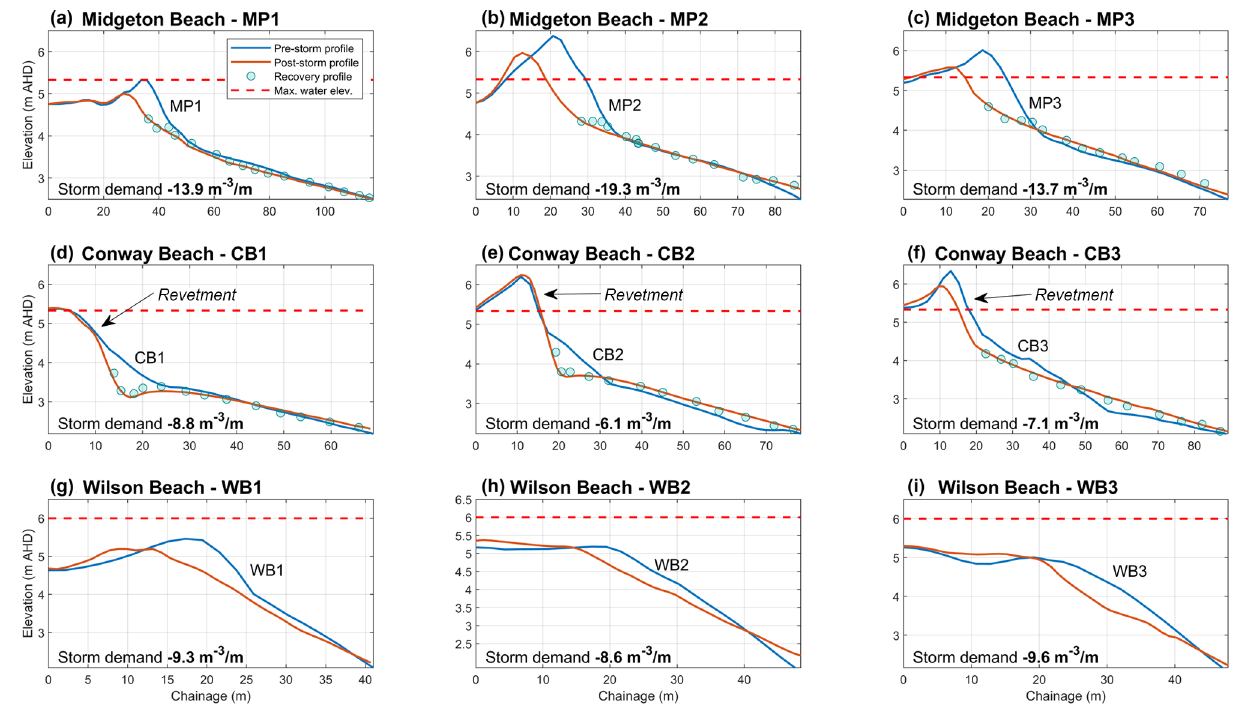
Figure 8. Cross-shore beach profile change at Midgeton Beach ( a – c ), Conway Beach ( d – f ) and Wilson Beach ( g – i ). Blue (orange) lines denote pre- (post-) storm profiles taken through the lidar DEMs (locations Fig. 9). Green circles show alongshore-averaged DGPS elevations along the same profile lines ∼ 5 months after Debbie . Only the lower “recovery” profile is shown at Midgeton Beach because heavy vegetation hindered DGPS data collection. Only the lower “recovery” profile is shown at Conway Beach because the upper portion is a revetment. No “recovery” profiles are shown for Wilson Beach because beach recharge occurred in the interim. Also shown is the estimate of maximum water elevation from Fig. 6 and storm demand. (f) indicates the revetment has moved during Debbie along profile CB3, consistent with observations (DSITI, 2017). The storm demand calculation for CB3 does not include the revetment